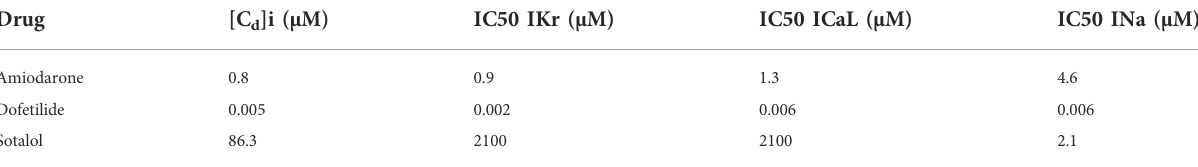
TABLE 1 Constants for drug